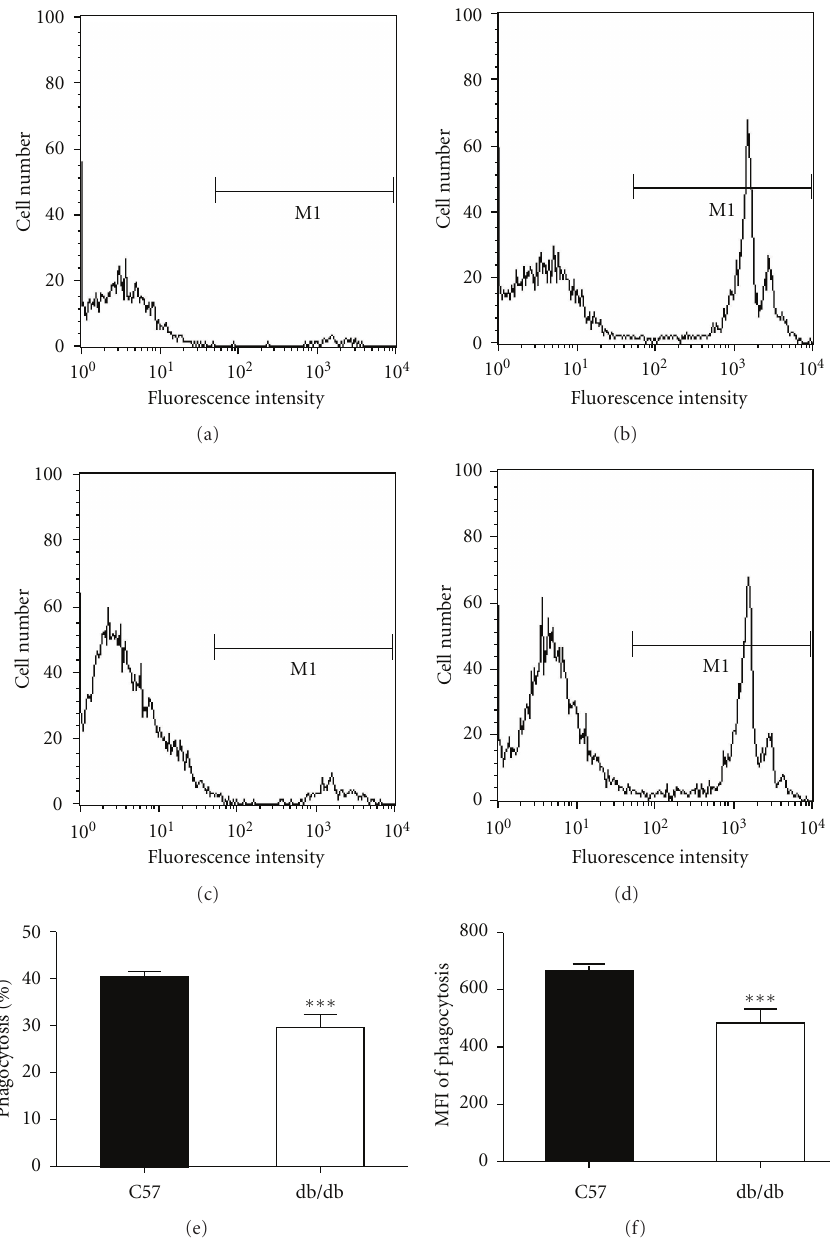
Figure 2: Decreased phagocytosis of polystyrene latex beads by F4/80 + RPMs in 5-month diabetic mice. One representative experiment of 4 detected by FCM showing RPMs from normal mice (b) and db/db mice (d) after incubated with fluorescence-modified polystyrene latex beads for 2 h at 37 ◦ C, wheals the control from normal mice (a) and db/db mice (c) were incubated at 4 ◦ C. The average phagocytic rate (e) and MIF (f) of four independent experiments were quantified. ∗∗∗ P < 0.001 between the indicated